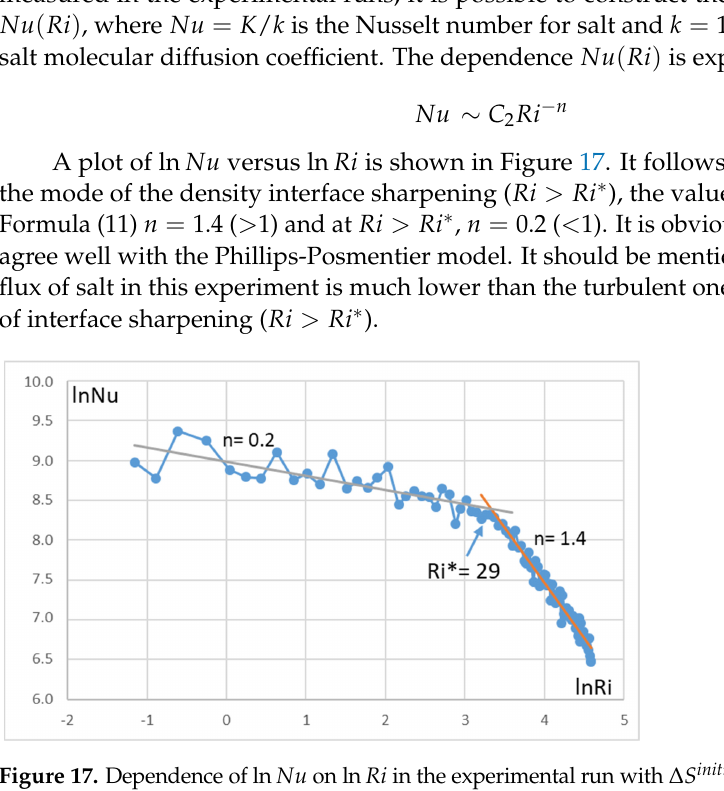
∆ S initial = 30 ppm and Re = 214.